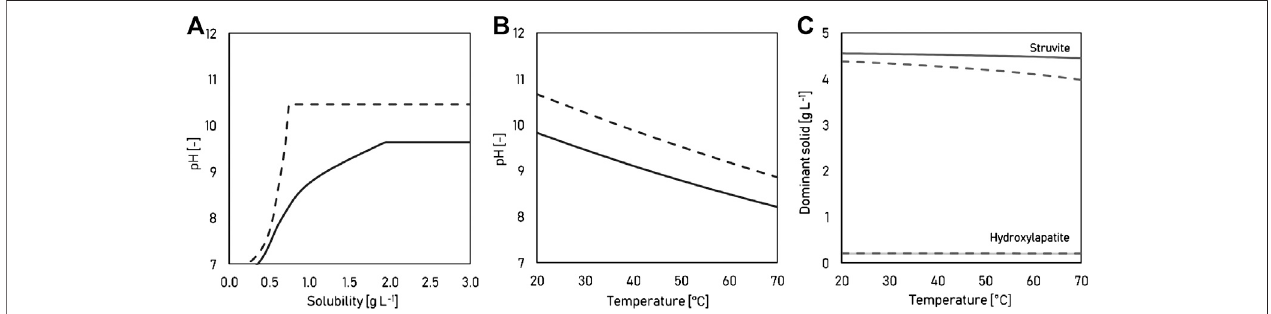
FIGURE1| Plotsshowthesimulated (A) pHofurinevs.thesolubilityofMgOat25 ° C; (B) pHofurinesaturatedwithMgOvs.temperature;and (C) dominantsolids (struvite and hydroxylapatite) formed in saturated urine at different temperatures. Solid line represents the urine composition of this study ( Table 1 ), while dashed line represents the same but with NH + 4 concentration reduced to 400 mg · L − 1 .